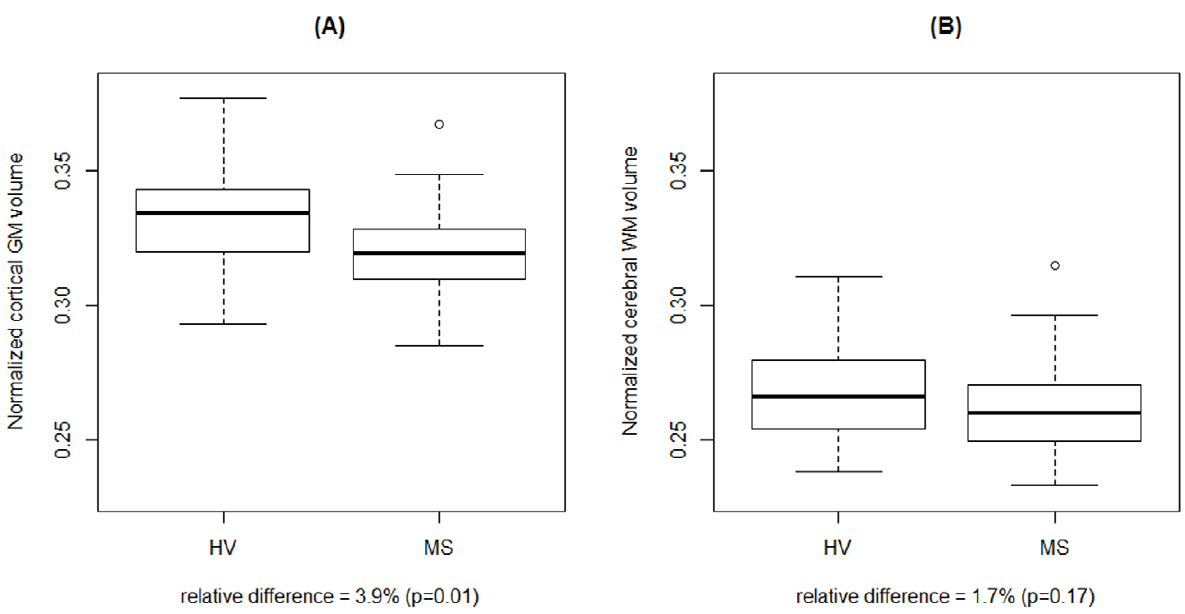
Figure 2. Distributions of normalized cortical gray matter (A) and cerebral white matter (B) volumes in healthy volunteers vs. MS cases. White matter volume is not significantly atrophic in the MS group, whereas cortical GM volume is substantially lower in MS.